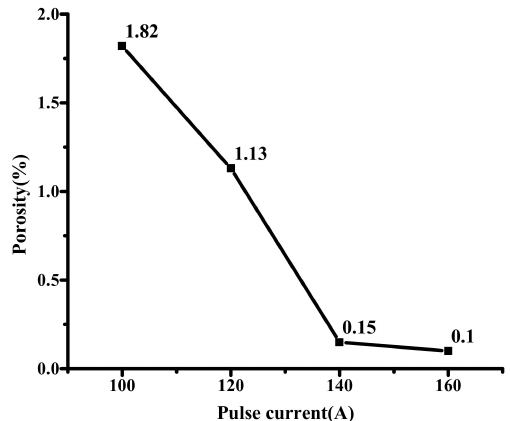
Figure 8. The pore distribution under di ff erent pulse currents.